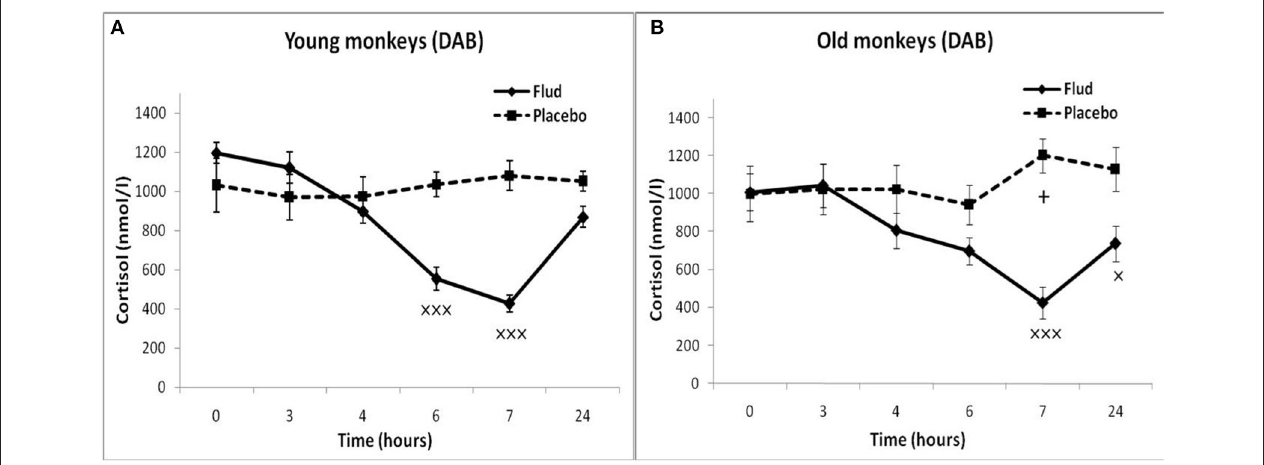
FIGURE 4 | Dynamics of CORT concentration in peripheral blood plasma of young and old female rhesus monkeys with DAB (A) in response to administration of fludrocortisone and placebo (mean ± S.E.M). + p < 0.05—age-related differences ( F = 7.363; df = 1;15; p = 0.022). × p < 0.05, ××× p < 0.001 vs. placebo; (B) : 7h ( F = 35.414; df = 1;14; p = 0.00079), 24h ( F = 6.994; df = 1;14; p = 0.019).